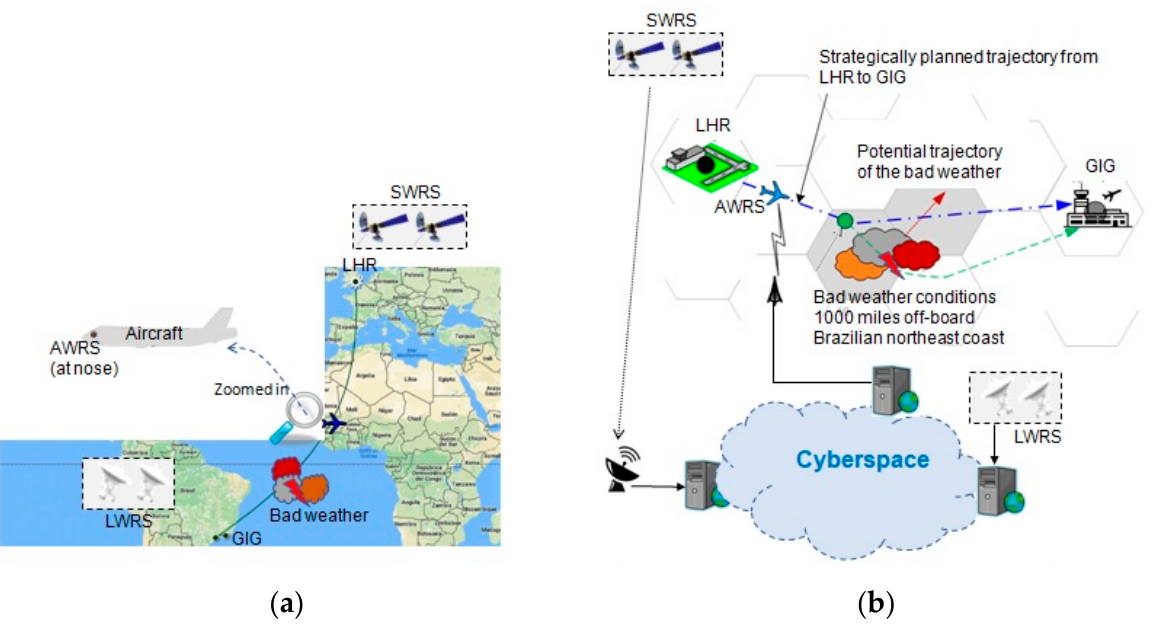
Figure 8. Scenario 1: ( a ) Airspace situation; ( b ) A cyber-physical view of the airspace situation.